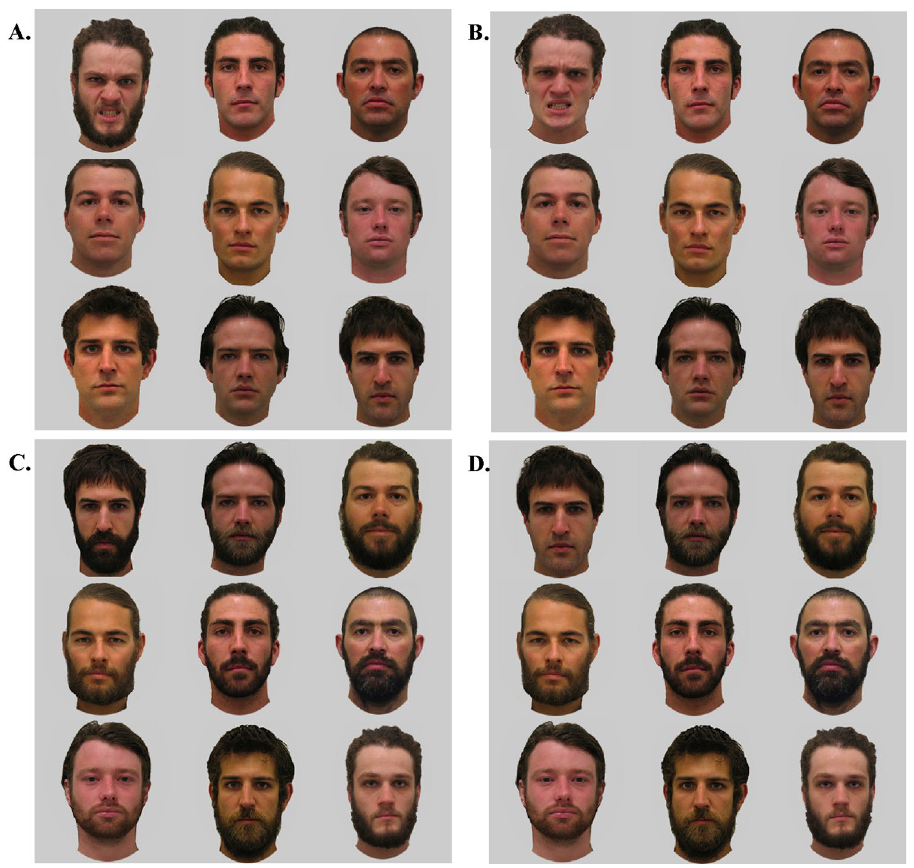
Figure 6. Example of four arrays from trials in Study 3. ( A) A bearded target angry face (top left face) in a uniformly clean-shaven background of neutral faces. ( B) Clean-shaven angry target (top left face) in a uniformly clean-shaven background of neutral faces. ( C) Non-target trial of uniformly bearded neutral faces. ( D) Non- target trial containing clean-shaven foil (top left face) in uniformly bearded